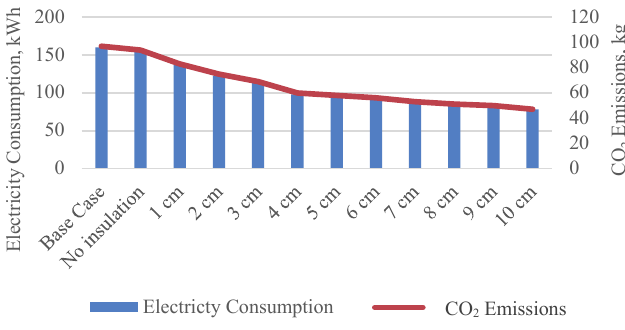
Fig. 5. Total Electricity Consumption and CO 2 emissions for Roof Construction Layers Simulation